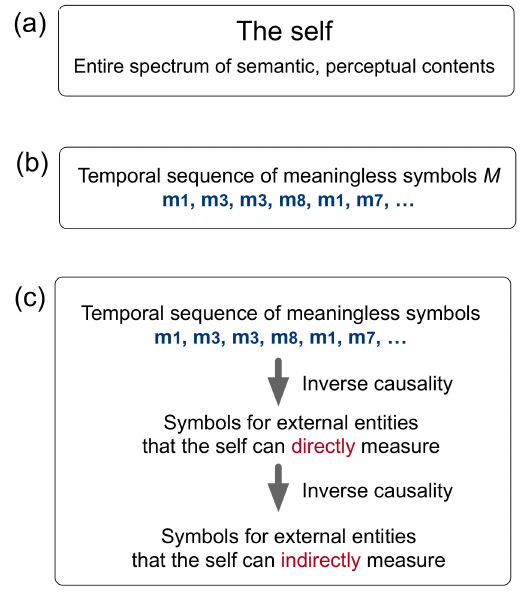
Figure 1. Overview of the previous study [23]. ( a ) The self is hypothetically modeled as an entire spectrum of percepts, which are not entailed (or caused) by something but given as they are. ( b ) The self is abstracted as a temporal sequence of meaningless symbols, which are given as they are. ( c ) New symbols referring to external entities are derived (entailed) from the meaningless sequence by the algorithmic operation of inverse